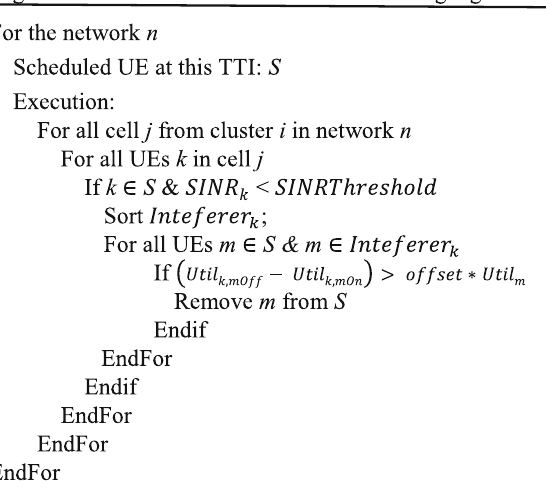
algorithm for P1: utility maximization. In the code, U til